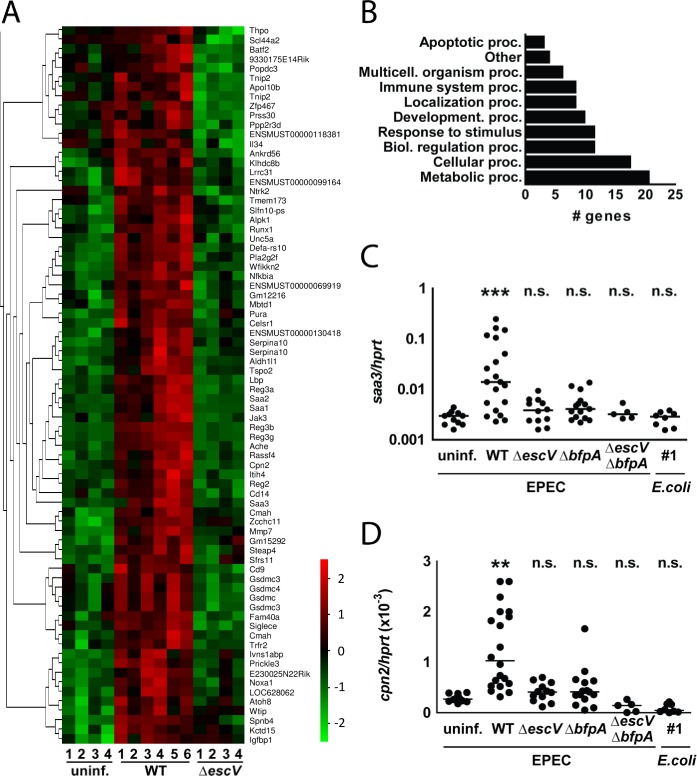
Characterization of the epithelial response to EPEC infection in vivo.
(A) Heat map showing the intestinal epithelial gene expression in small intestinal tissue of uninfected mice (uninf.) as well as at day 8 p.i. with WT EPEC or escV mutant (n = 4–6 from at least 2 litters). A selection of the most significantly up-regulated genes following WT EPEC infection are shown (p-value = 0.02; q-value = 0.22). (B) Clusters of orthologous group (COG) analysis of the genes shown in (A). (C-D) 1-day-old mice were orally infected with WT EPEC, escV mutant, bfpA mutant, escV/bfpA double mutant EPEC, a murine commensal E. coli strain or left untreated. IEC were isolated from the small intestinal tissue at 8 days p.i. and the expression levels of (C)
saa3 and (D)
cpn2 were determined by quantitative RT-PCR and normalized to the values obtained for the housekeeping gene hprt (n = 4–16 from at least 2 litters; median). Kruskal-Wallis ANOVA with Dunn’s multiple comparison post-test (C-D). ns, p>0.05; **, p<0.01; ***, p<0.001.